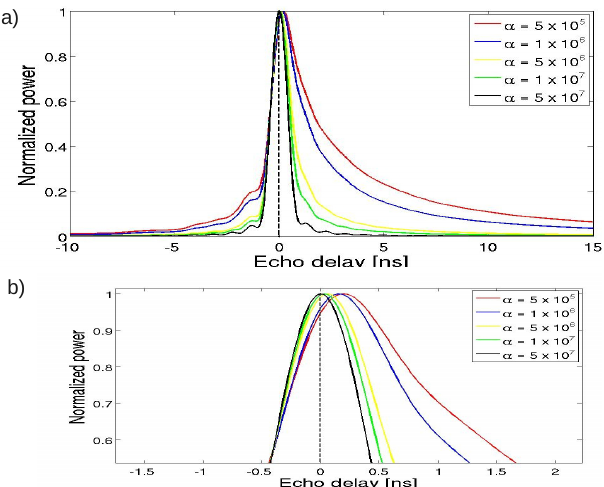
Figure 3. Simulated CryoSat-2 echoes over sea ice leads for σ = 0 . 02m and (a) the typical range of α observed over sea ice floes, and (b) a zoomed-in plot showing the behavior near the echo delay time of